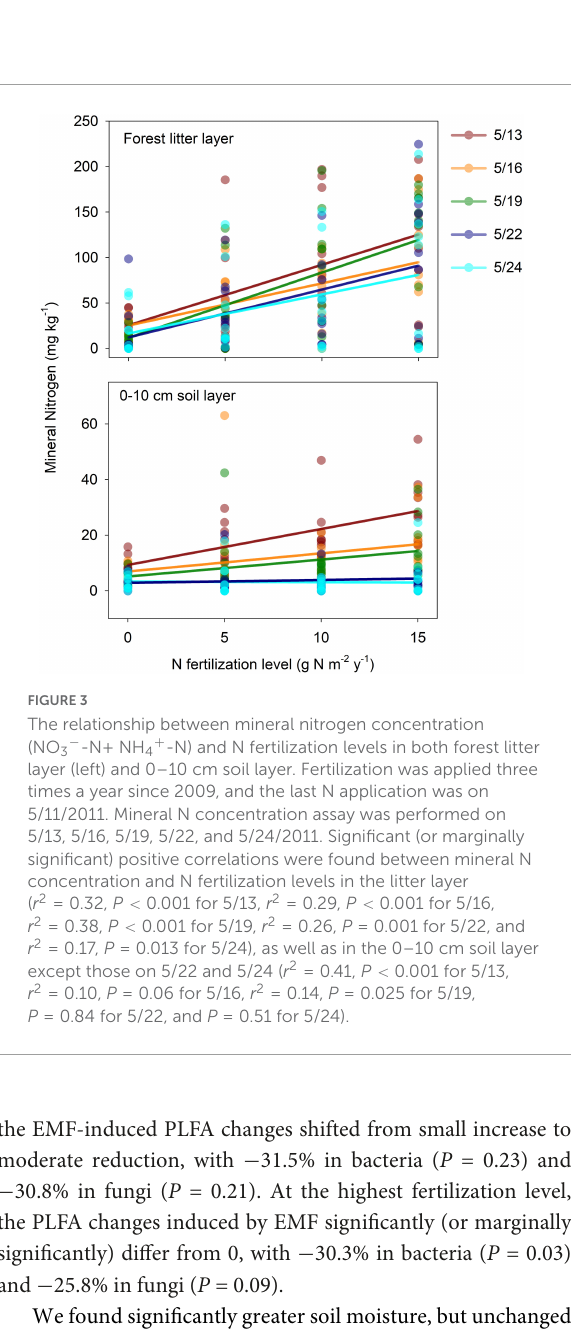
( Table 1 ), and exhibited exponential relationships with soil temperature for both tube treatments ( Figures 5A,B ). The